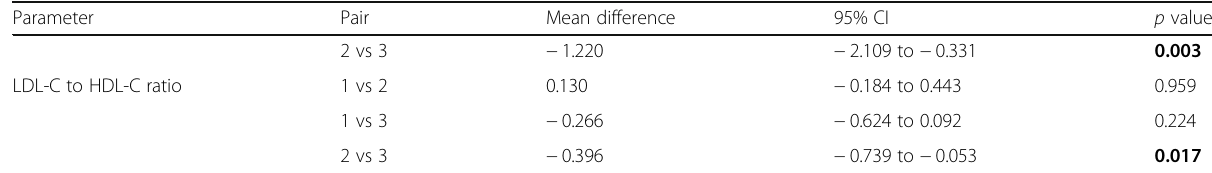
Table 2 Post hoc analysis with a Bonferroni adjustment for study parameters (Continued)